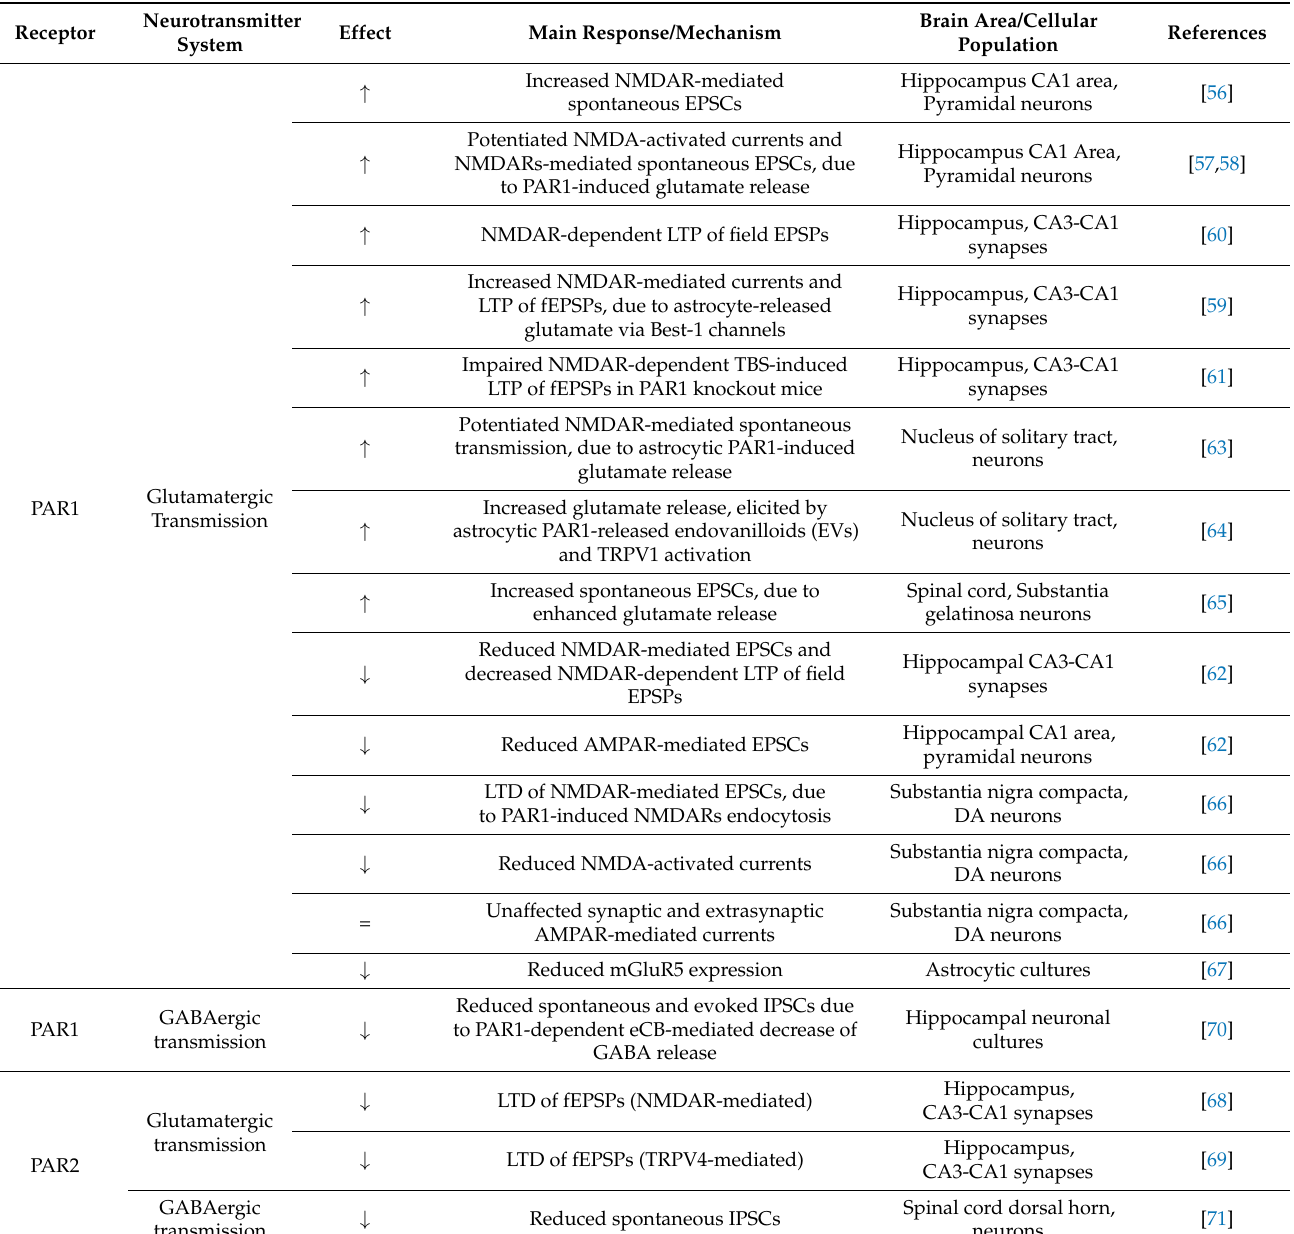
Table 2. Roles of PARs (PAR1 and PAR2) in the modulation of neurotransmission and synaptic plasticity.